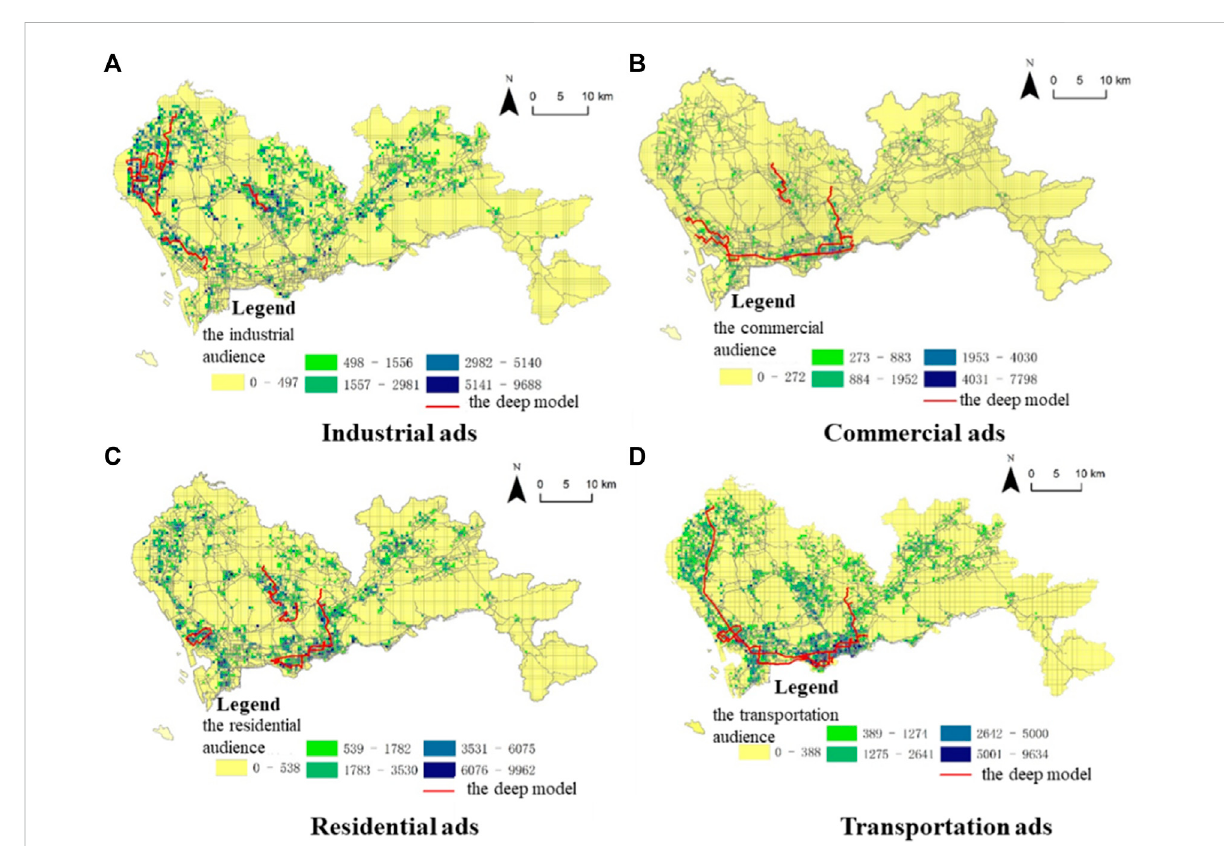
FIGURE 9 The selected bus routes of the deep coverage-oriented model for (A) Industrial ads, (B) Commercial ads, (C) Residential ads, (D) Transportation